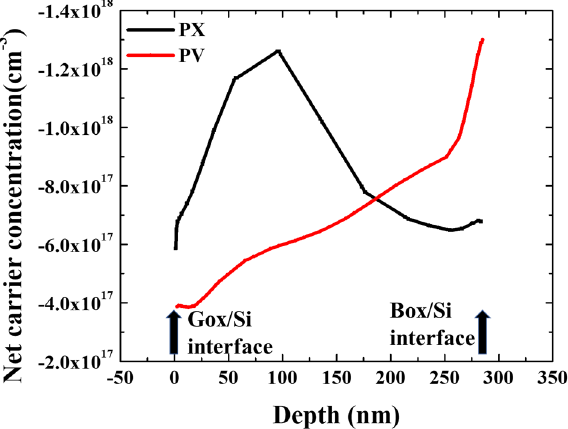
Figure 7. The simulated net carrier concentration profile in the whole silicon from the gate ox- ide/silicon (Gox/Si) front interface to the buried oxide/silicon (Box/Si) back interface in PX devices and PV devices.